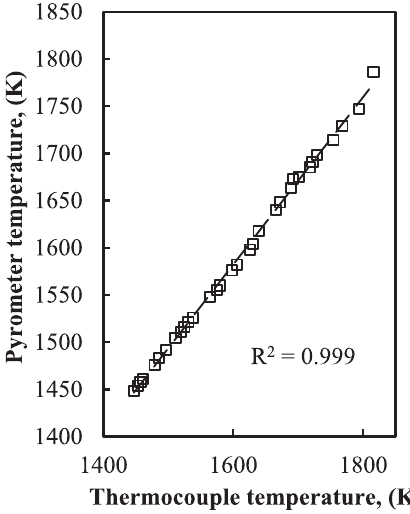
Fig. 4: Pyrometer calibration results obtained using the assembly shown in Figure 3